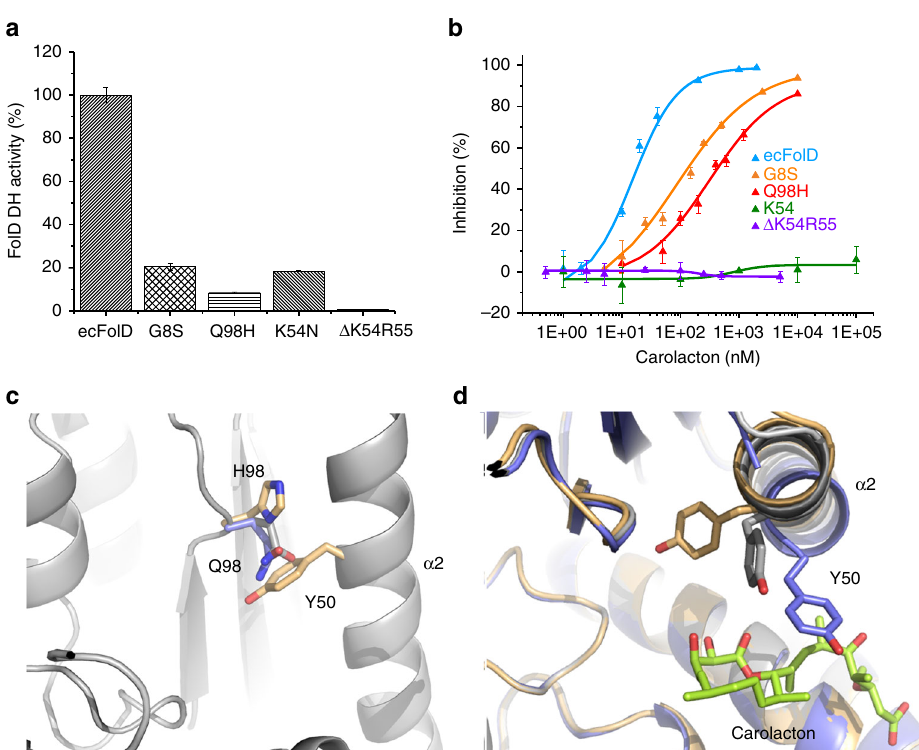
Fig. 3 Effects of FolD mutations on DH activity and carolacton binding. a Residual DH activity of ecFolD mutants compared to ecFolD. Data are presented as means ± s.e.m of three independent replicates. DH speci fi c activities were calculated based on the V max obtained via Michaelis – Menten fi tting. The one- way ANOVA test was used for statistical analysis, P < 0.01. b IC 50 determination for carolacton against the DH activity of ecFolD and mutants. Data are presented as means ± s.e.m of three independent replicates. IC 50 s were obtained via logistic dose – response fi tting. The one-way ANOVA test was used for statistical analysis, P < 0.01. c Position of Y50 in ecFolDQ98H (gold). The position of Q98 in the apo (grey) and complex (blue) structures prevents the side-chain of Y50 from rotating out of position. d Position of Y50 in the apo (grey), complex (blue) and Q98H (gold) structures. The 90° rotation of Y50 in the Q98H mutant prevents Y50 from forming the hydrophobic lid on carolacton (lime